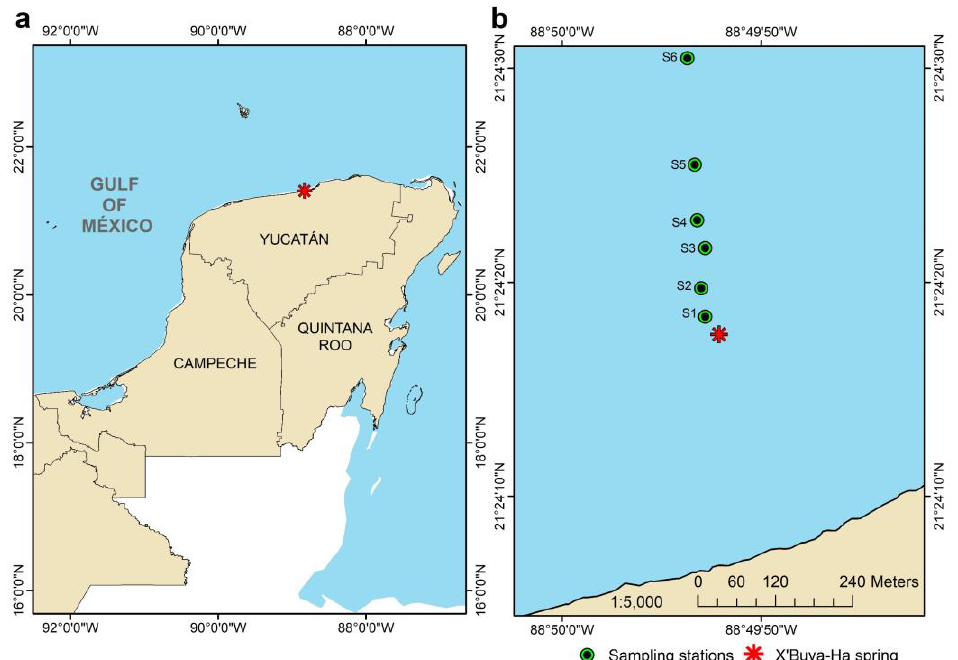
Figure 1. Map showing the Yucat á n Peninsula, M é xico, and the location of the study site (red asterisk) ( a ). Transect with the six sampling stations (green and black circles) established along a 400 m gradient in Dzilam de Bravo, Yucat á n. X’Buya-Ha spring is shown by a red asterisk ( b ). Rhizospheres from H. wrightii monospecific stands, water, surrounding sediment and porewater samples were collected in August 2021 along a 400 m transect under the influence of submarine groundwater discharges (SGD) in Dzilam de Bravo, Yucat á n, M é xico (Figure 1b). Six sampling stations (S1–S6) were established starting at 32 m north of X’Buya- Ha spring (Figure 1b). Less energetic springs were also observed near stations S3 and